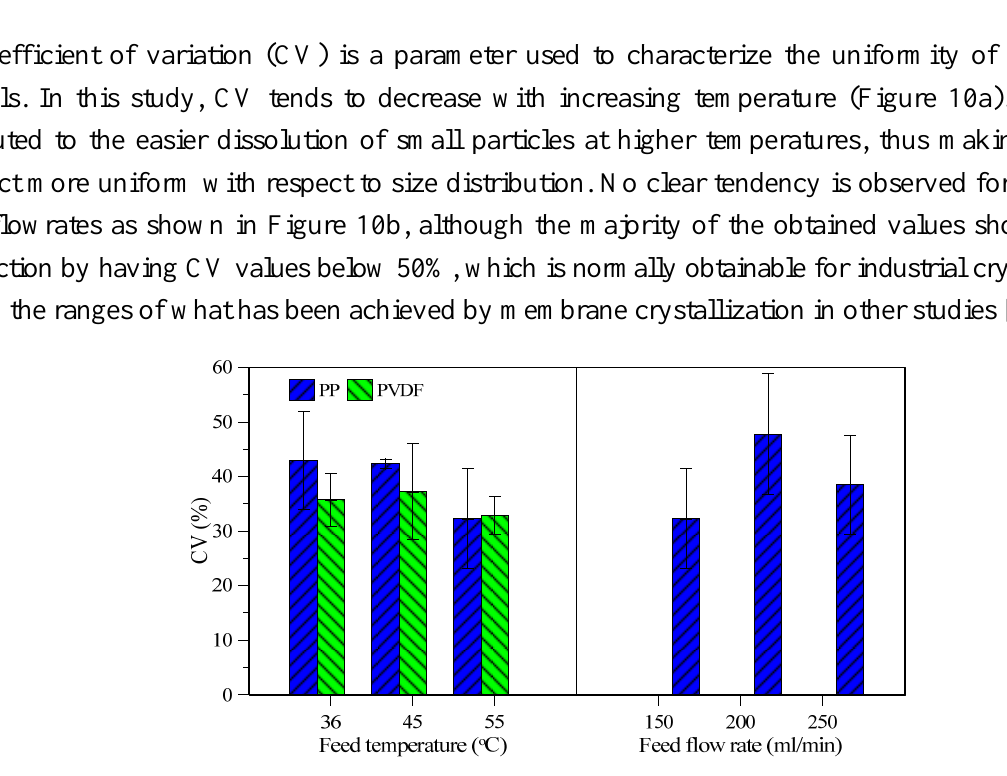
Figure 9. Growth rate of the produced crystals at different feed temperatures and feed flow rates (( a , b ) respectively).